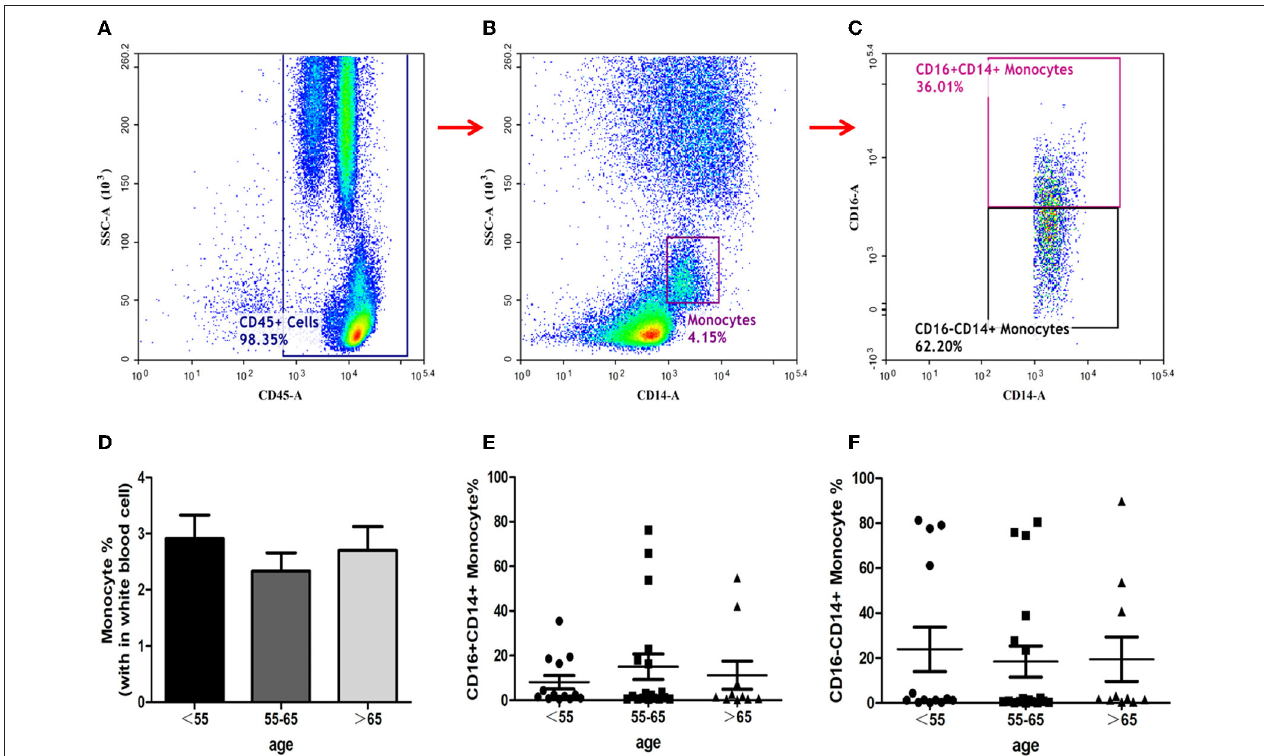
FIGURE 3 | Identification of monocytes and analysis of its subsets. Monocytes identification with the gating strategy. (A) : CD45 + cells. (B) : Monocytes. (C) : CD16 + CD14 + Monocytes; CD16 − CD14 + Monocytes. Percentages of monocyte subsets among the 3 groups. (D) : Monocytes. (E) : CD16 + CD14 + Monocytes. (F) : CD16 − CD14 +